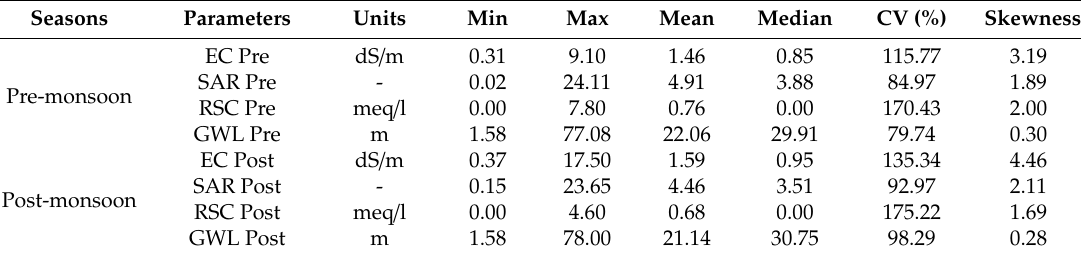
Table 1. The statistical summary of groundwater properties in 2015 ( n = 242).